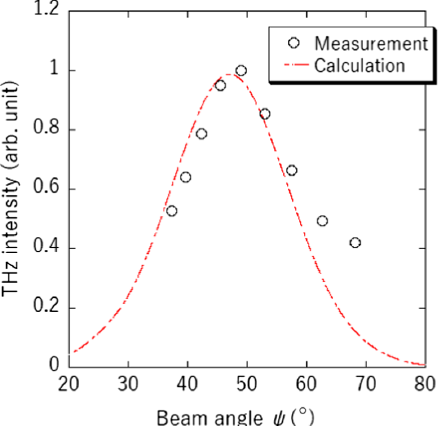
FIG. 5. Comparison of calculated and measured values in the relationship between beam angle and THz intensity. The mea- sured values are the average of six data around the beam shift ¼ 0 mm of each angle taken from Fig. 4(a).